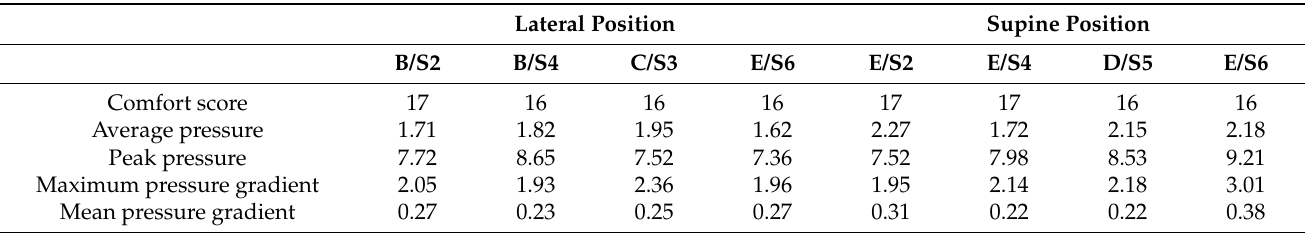
Table 3. Body pressure distribution index of top four